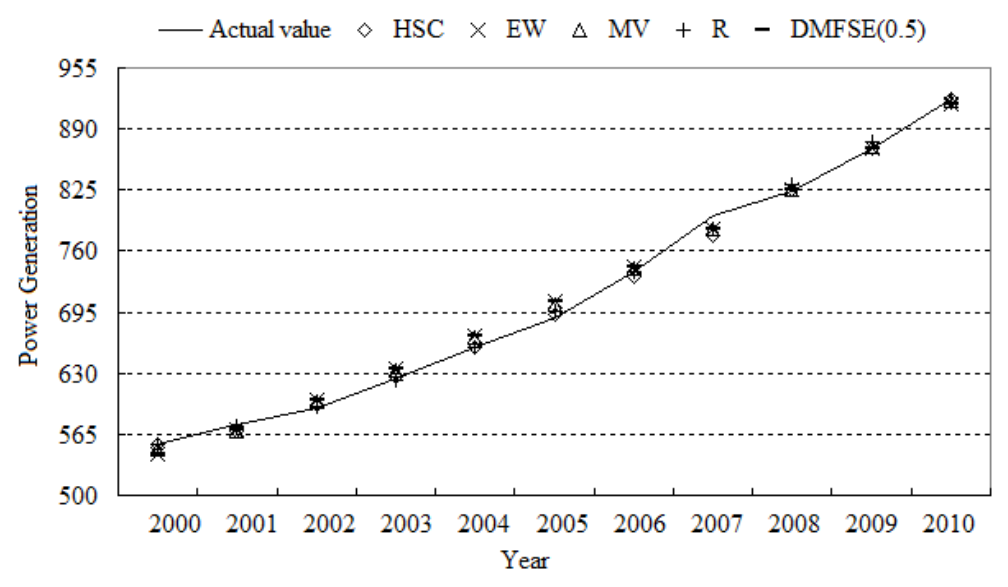
Figure 9. Forecasting performance of the HS-based JPOC model and the other combination models for